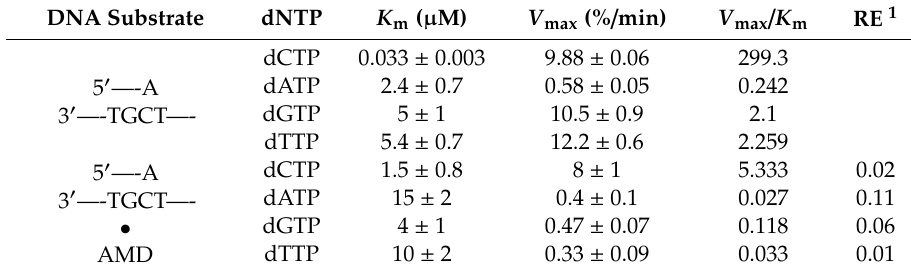
Table 1. Kinetics of Incorporation by KF − of dNTPs opposite the G Platinated by AMD. DNA Substrate dNTP